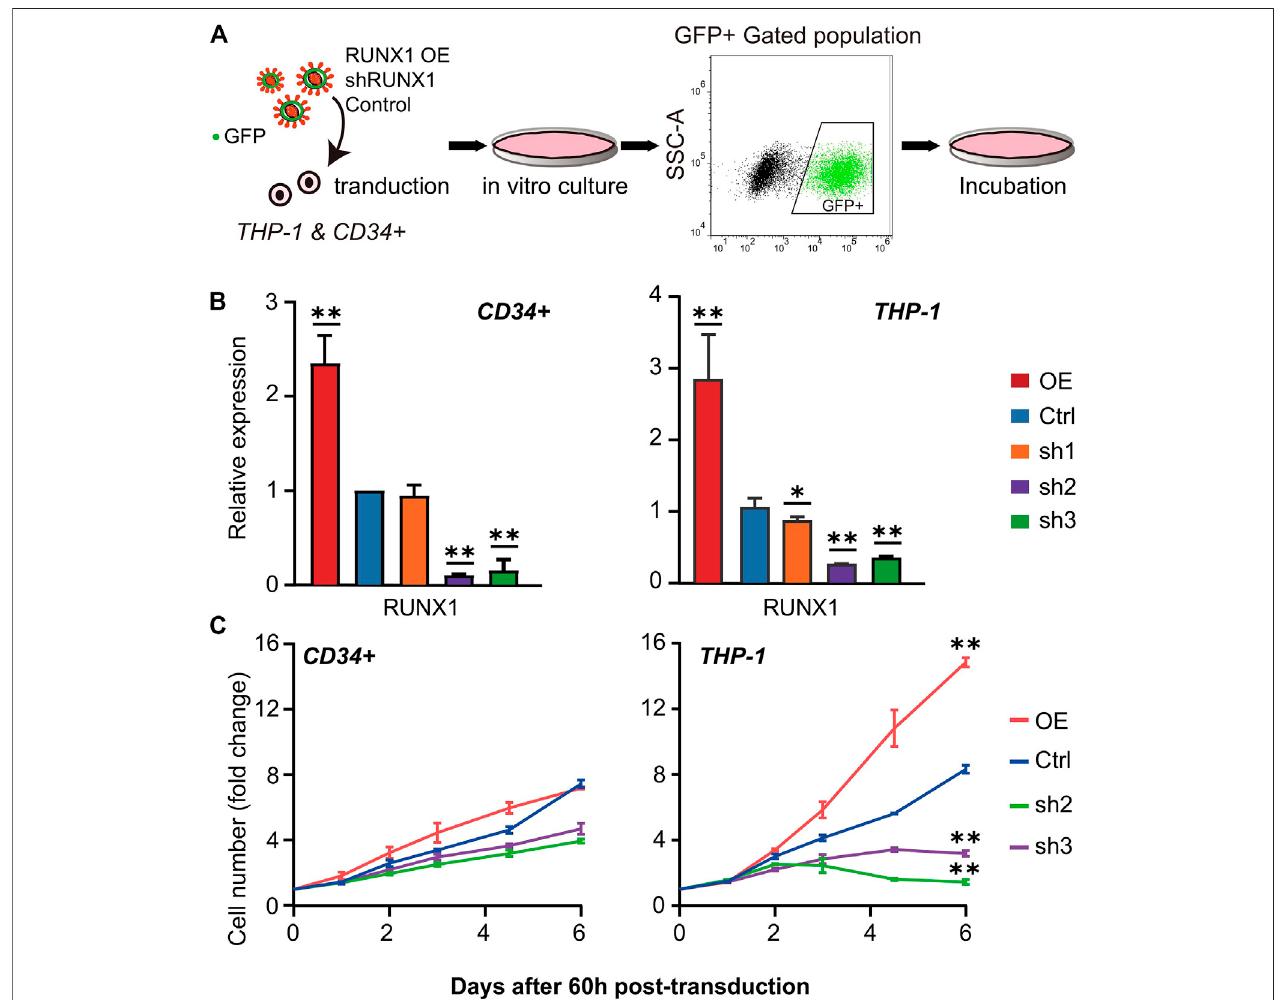
FIGURE 2 | Cell number phenotype caused by RUNX1 overexpression (OE) and knockdown (KD). (A) Scheme of lentivirus transduction experiments. RUNX1 OE and KD virus were transducted into THP-1 and CD34 + cells. After FC sorting, GFP + cells were transferred into fresh medium and culture in vitro for further experiment. (B) qRT-PCR con fi rmed the relative RUNX1 mRNA expression of THP-1 and CD34 + cells with empty vector, RUNX1 and RUNX1 shRNA in vitro . ALL groups were compared with Ctrl. All reactions were normalized against GAPDH. (C) THP-1 and CD34 + cells were transfected with the RUNX1 and RUNX1 shRNA